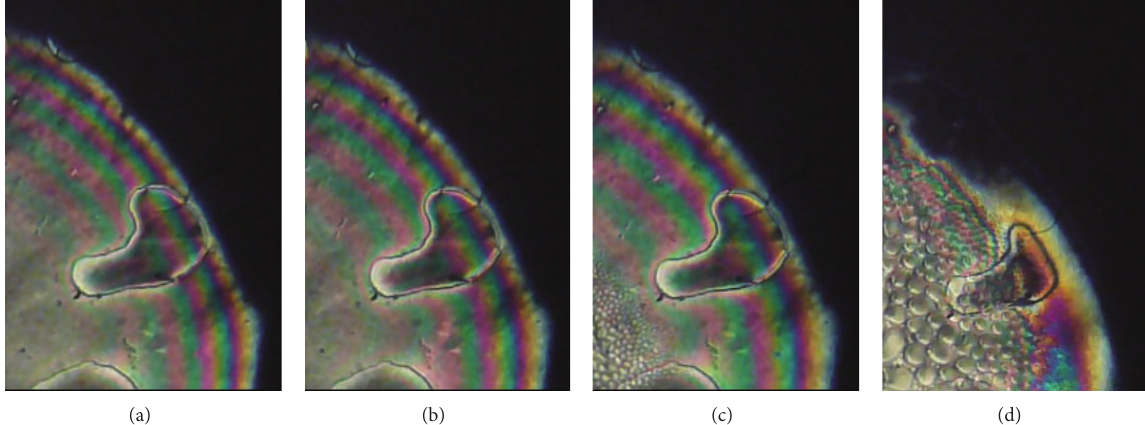
Figure 2: Typical sequence of changes observed in nematic droplets through crossed polarizers (compared to stages in Figure 1): (a) before injection of VOC, (b) interference pattern change, (c) bubbles formation, and (d) beginning isotropisation.